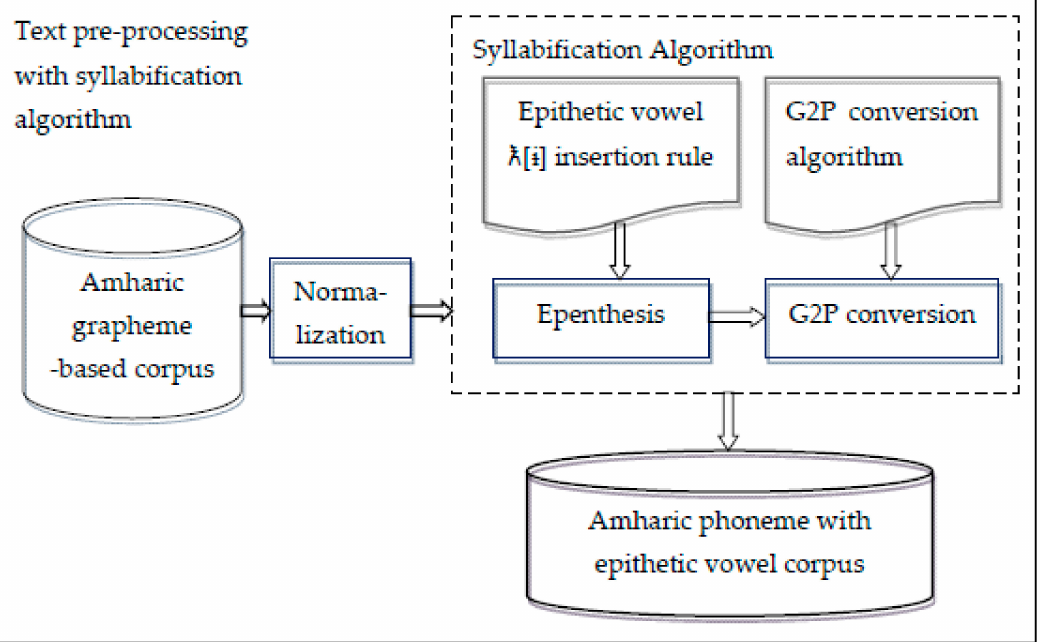
Figure 2. Overall text pre‑processing using a syllabification